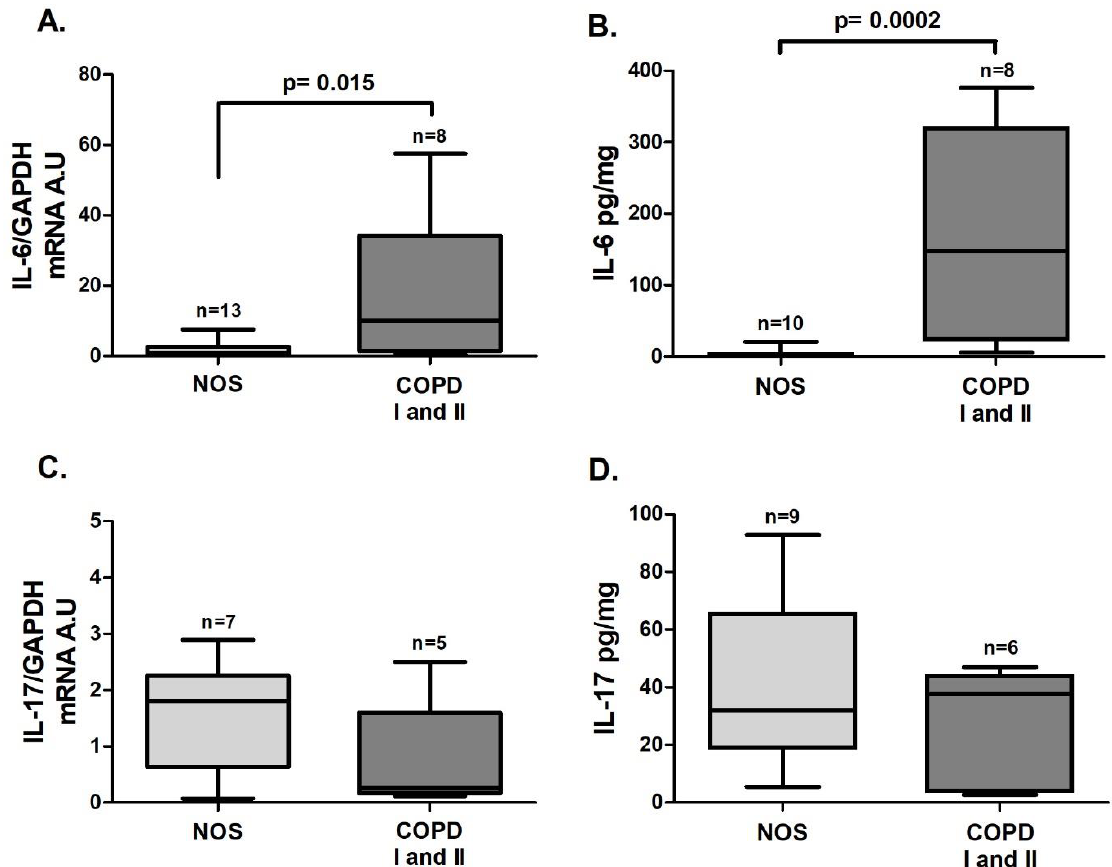
Figure 2. Th17-related cytokines in lung tissue samples. Th17-related cytokine expression in lung tissue samples: ( A ) increased IL-6 gene expression ( p = 0.015, Mann–Whitney test) and ( B ) IL-6 levels ( p = 0.0002, Mann–Whitney test) in the COPD I and II group. No differences were observed for IL-17 gene expression ( C ) (Mann–Whitney test) or IL-17 levels ( D ) (Mann–Whitney test) between groups. The data are expressed as the median and interquartile range. A.U: Arbitrary Units.